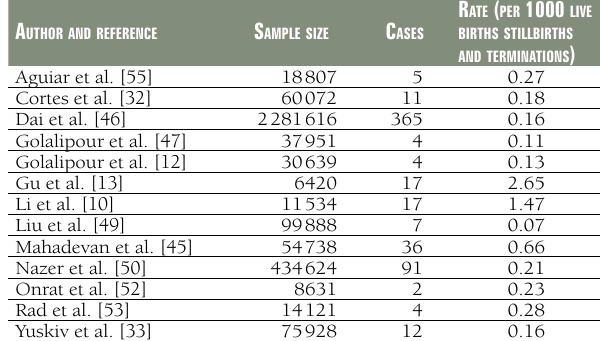
Table 11. Studies that reported rates for the burden of encephalo- cele based on live births, stillbirths and terminations of pregnancy a utHor aNd refereNCe s ample size C